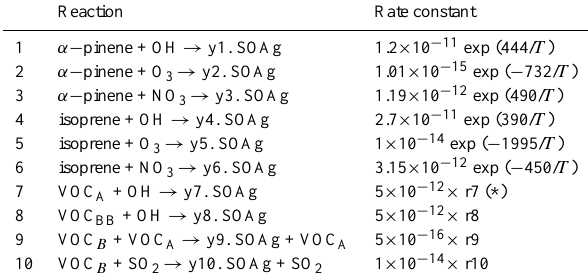
Table 1. Reactions of VOCs: anthropogenic (VOC A ) , biomass burning (VOC BB ) and biogenic (isoprene and α -pinene; VOC B ) to produce an assumed condensable product (SOA g ) with yield (y1 to y10). The reaction rate of Reactions (7–10) were scaled by a linear factor (r7 through